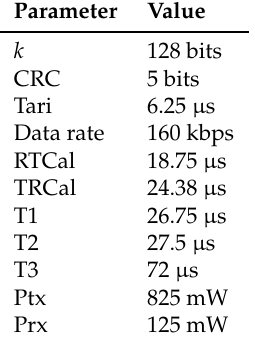
Table 1. Calculation of transmitted bits used in simulation.